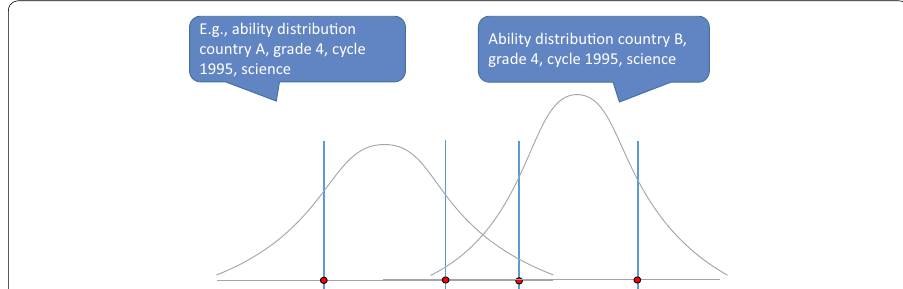
Fig. 2 Ability distributions vary greatly among countries